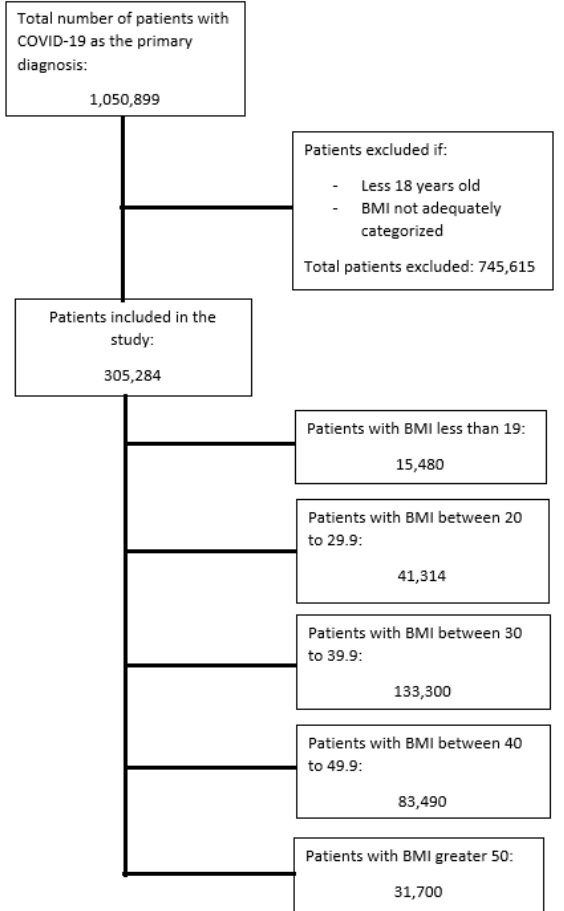
Figure 1. Selection of patients in the study. Table 1. Patient baseline characteristics.